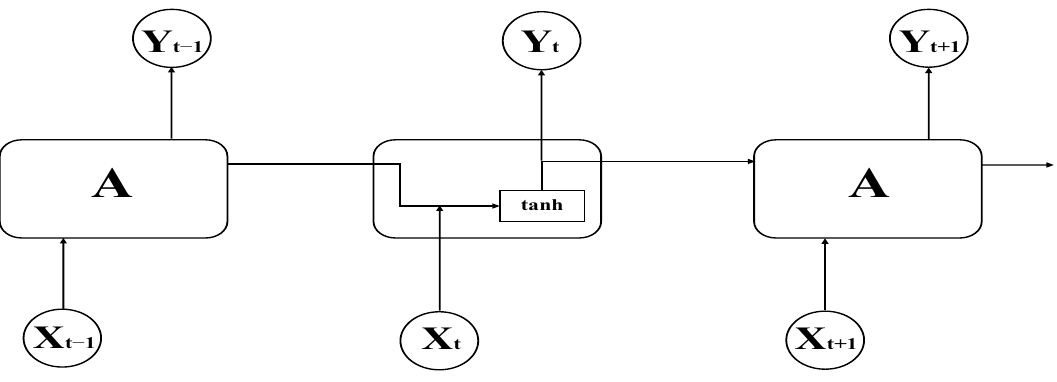
Figure 2. The schematic diagram of RNN network.